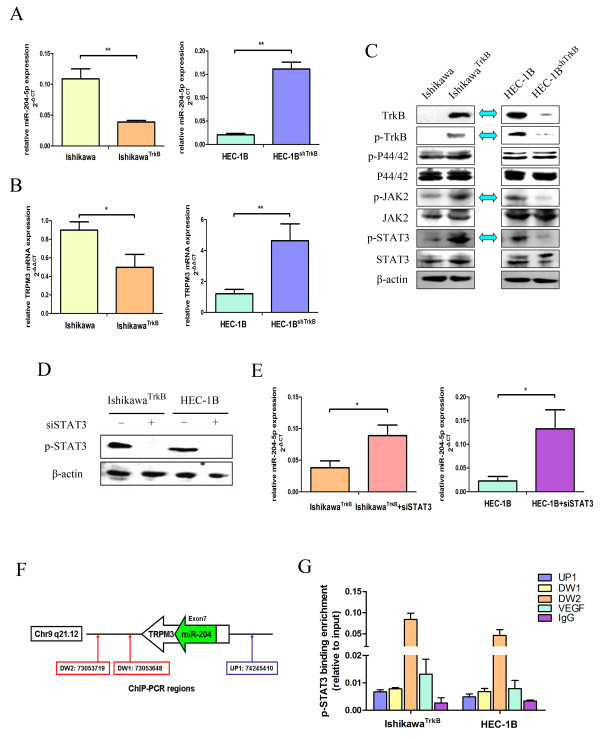
TrkB represses miR-204-5p expression by activating the JAK2/STAT3 pathway. (A) TrkB inversely regulates miR-204-5p expression and (B)TRPM3 mRNA expression in endometrial cancer cells. MiR-204-5p and TRPM3 mRNA levels in Ishikawa and IshikawaTrkB cells and HEC-1B and HEC-1BshTrkB cells were measured by quantitative RT-PCR. MiR-204-5p expression was normalized against U6B and TRPM3 mRNA expression was normalized against β-actin. Data are expressed as mean ± SD of at least three independent experiments. **P < 0.01 and *P < 0.05. (C) TrkB, phospho-TrkB, phospho-P44/42, P44/42, JAK2, STAT3, phospho-JAK2 and phospho-STAT3 in Ishikawa and IshikawaTrkB cells and HEC-1B and HEC-1BshTrkB cells were assessed by Western blotting assays. Representative blots are shown. Blue arrows show the opposite changes in the two cell lines. (D) IshikawaTrkB and HEC-1B cells were transfected with siSTAT3, and phospho-STAT3 was assessed by Western blotting assays. (E) Inhibition of STAT3 increases miR-204-5p expression in IshikawaTrkB and HEC-1B cells. Data are expressed as mean ± SD of at least three independent experiments. *P < 0.05. (F) Schematic representation of the miR-204-5p locus and its host gene, TRPM3. STAT3-binding sites around the TRPM3 start site (UP1, DW1, and DW2) are predicted by in silico analysis. Chromatin immunoprecipitation assays were performed using anti-phospho-STAT3 antibody or rabbit isotype IgG. Immunoprecipitated DNA fragments were examined by quantitative real-time PCR (G). Data in (G) represent mean ± SD of at least three independent experiments performed in triplicate. VEGF was used as positive control and IgG as negative control.